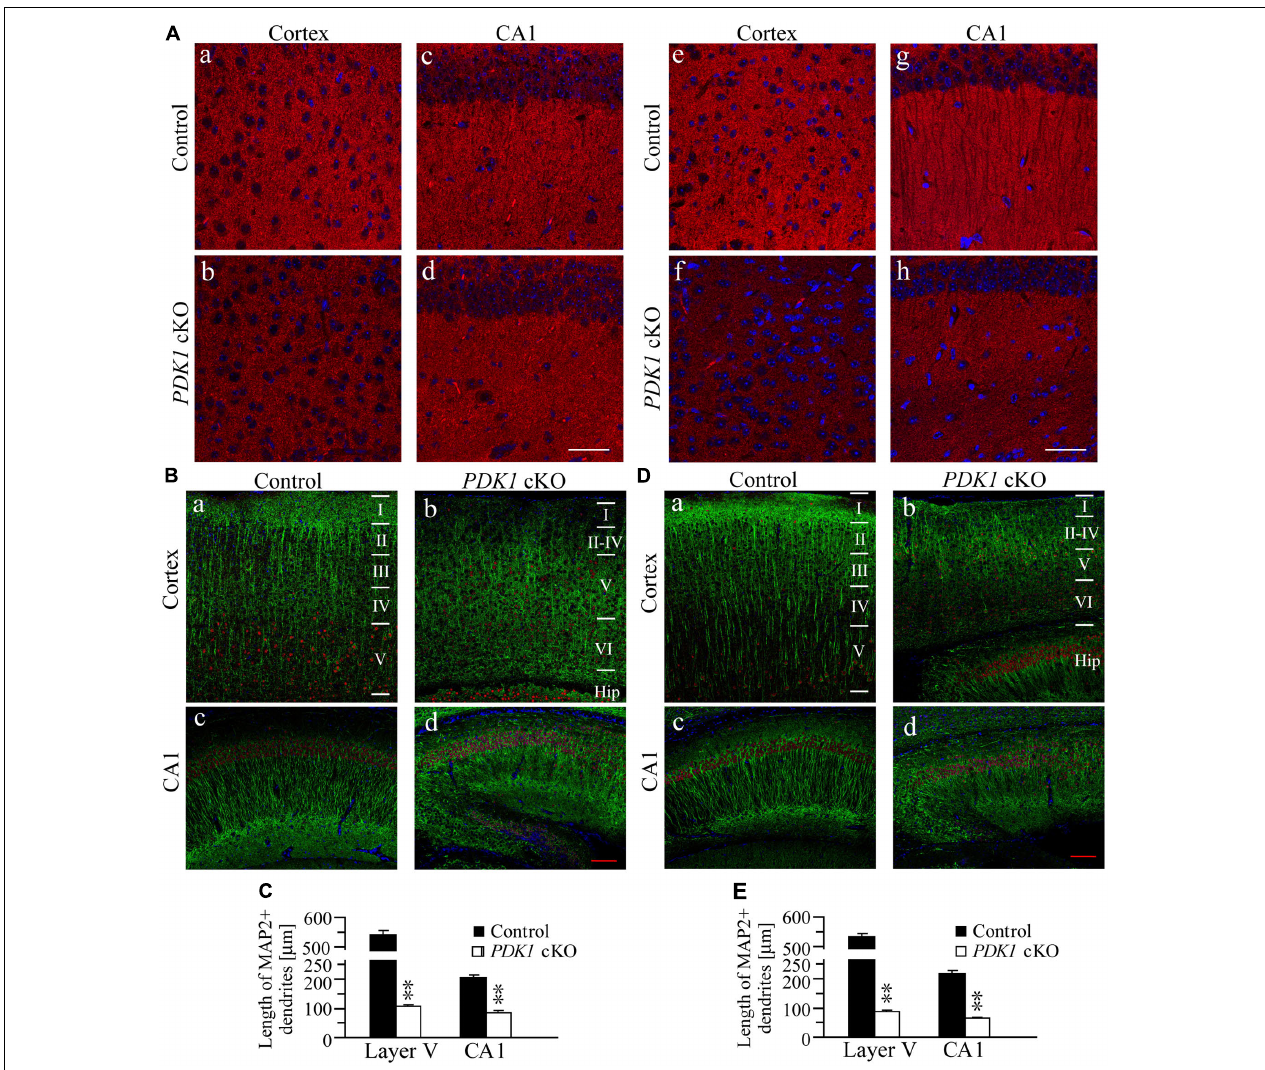
FIGURE 3 | Loss of synapses and dendrites in PDK1 cKO mice. (A) IHC for SVP38. Qualitatively altered immunoreactivity of SVP38 in the cortex and the hippocampus in PDK1 cKO mice aged at 3 weeks (a–d) or 3 months (e–h). Scale bar = 100 µ m. (B) Double-staining of MAP2/Ctip2 in the cortex (a,b) and the hippocampus (c,d) of mice at 3 weeks. Dendrites, neurons, and cell bodies were labeled by MAP2 (green), Ctip2 (red), and DAPI (blue), respectively. Scale bar = 100 µ m. (C) There were significant differences on the averaged dendritic length for neurons in layer V of the cortex and in hippocampal CA1 area of control and PDK1 cKO mice (30 Ctip2+ neurons from 3 mice per brain area per group; ∗∗ p < 0.01). (D) Double-staining of MAP2/Ctip2 in mice at 3 months (a–d). Scale bar = 100 µ m. (E) The averaged length for dendrites was significantly different between two groups (30 Ctip2+ neurons from 3 mice per brain area per group; ∗∗ p <